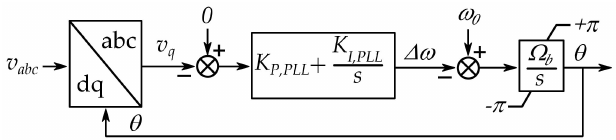
Figure 4. Block diagram showing PLL implementation based on orientating the reference axis to the measured grid voltage such that the quadrature component of the voltage, v q , becomes zero.